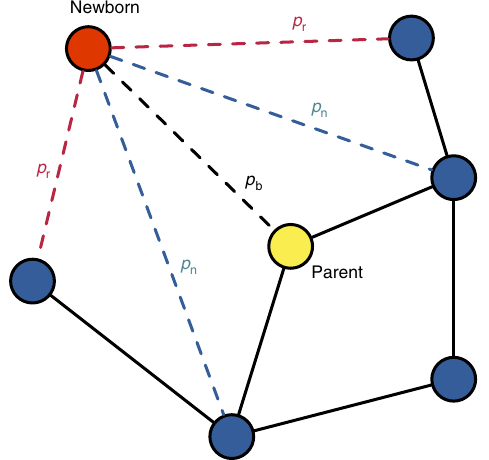
Figure 1 | Graphical illustration of the model. A newborn individual is connected to its parent with probability p b , to its parent’s connections with probability p n and to individuals not directly connected to its parent with probability p r .